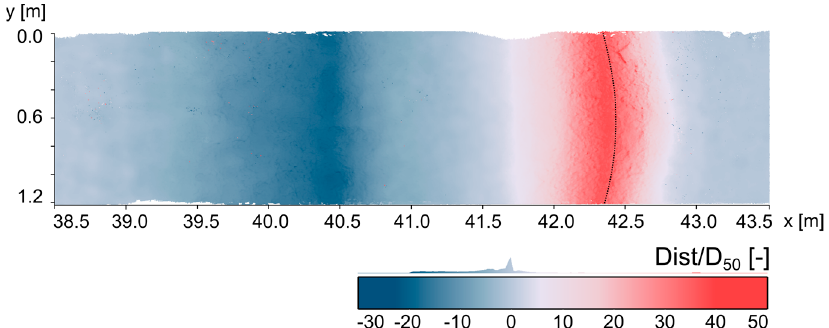
Figure 6. Relative distance (Dist/D 50 ) between initial and equilibrium beach profile for the No Structures test under large waves conditions (LWD18_v2, T p = 2.51 s, H s = 0.20 m) with visible convex shape of the berm.